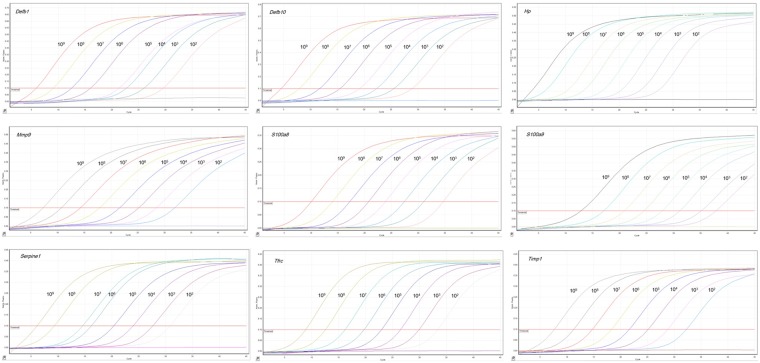
Amplification plots of the biomarker genes in the real-time PCR.Real-time PCR was conducted with PCR product that serially diluted 10-fold from 109 to 102 copy numbers. The emission of fluorescence was measured at each cycle numbers and negative control sample with no template DNA showed no increasing of fluorescence.